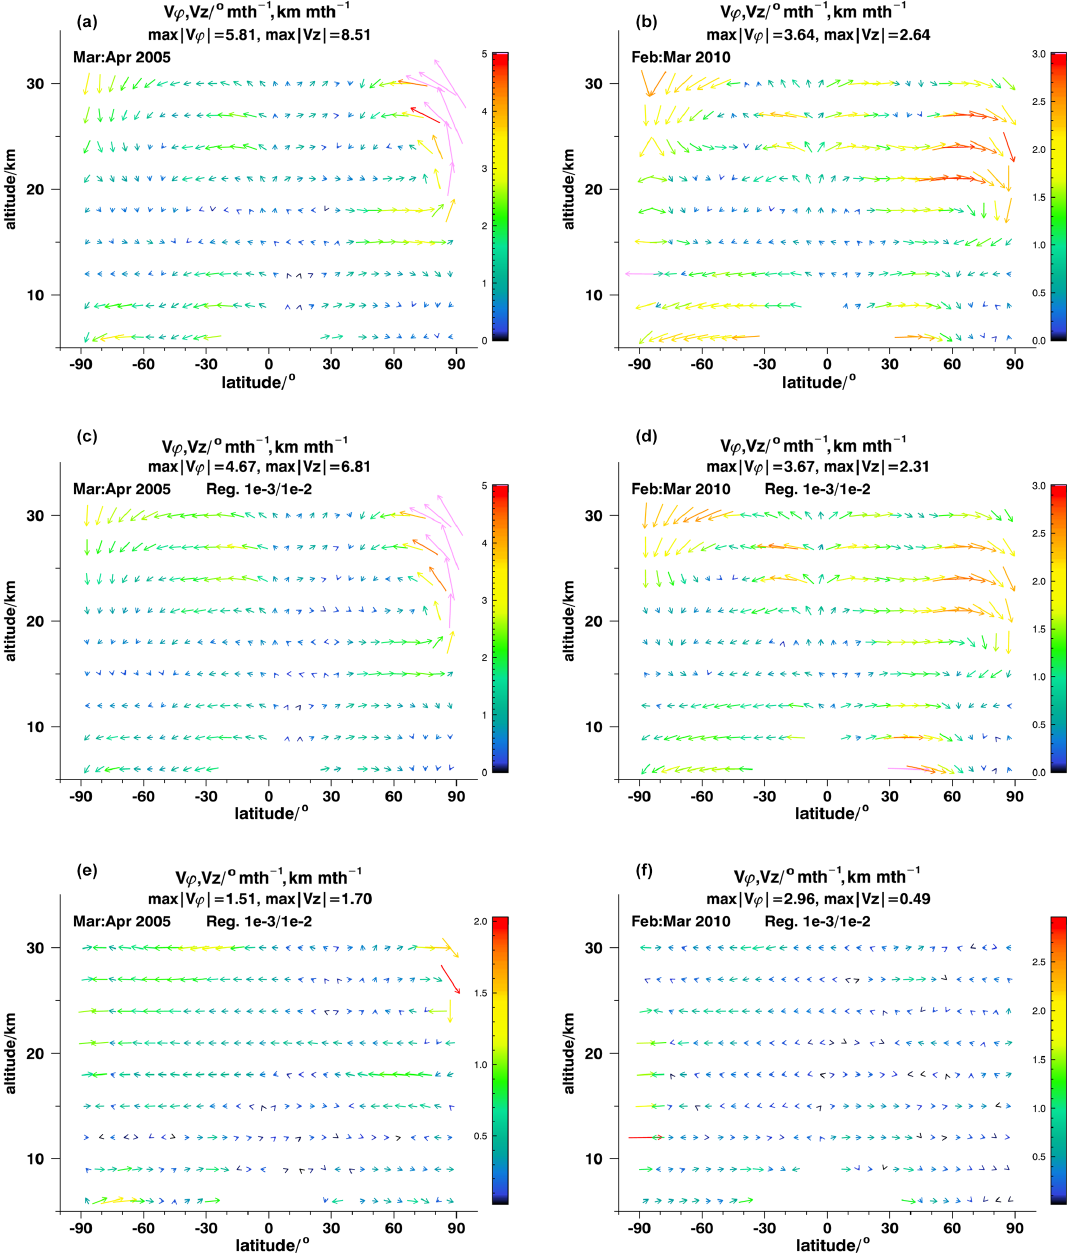
Figure 5. As for Fig. 3 but with a reduced altitude range for clearer representation of lower altitudes.